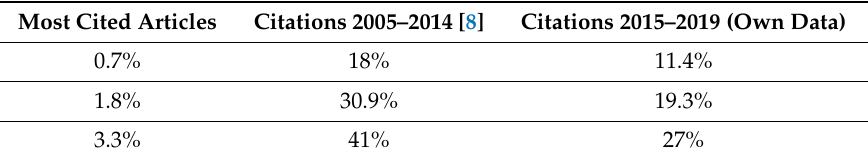
Table 12. Most cited articles and their part of citations (sources: [8]; own data).